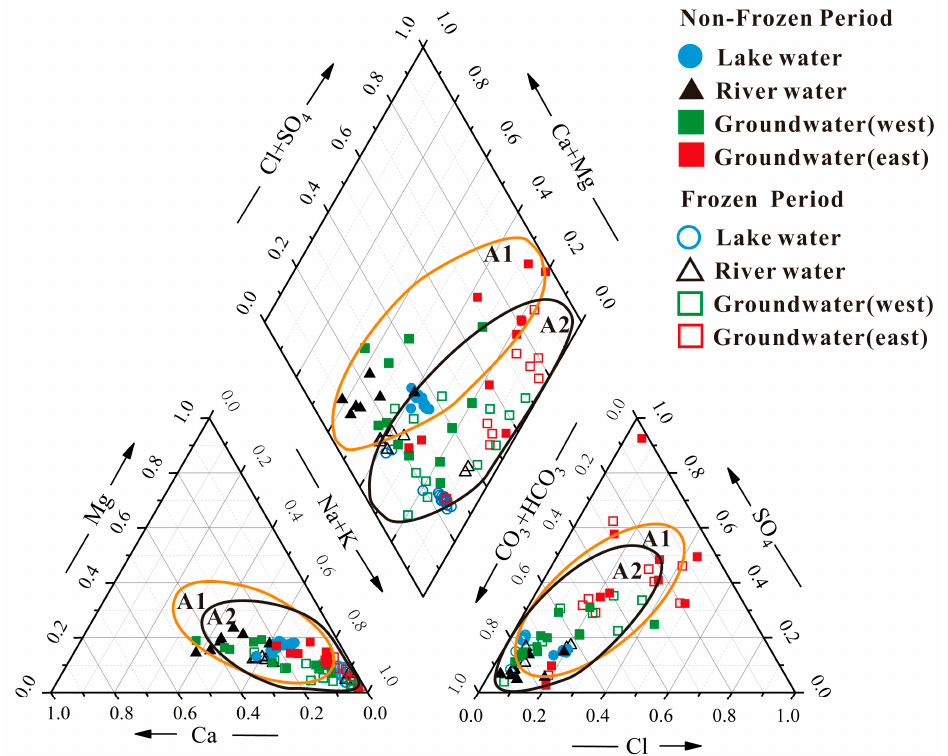
Figure 2. Piper diagrams of groundwater chemical concentrations in different seasons in each water body in the study area. A1: non-frozen period; A2: frozen period.